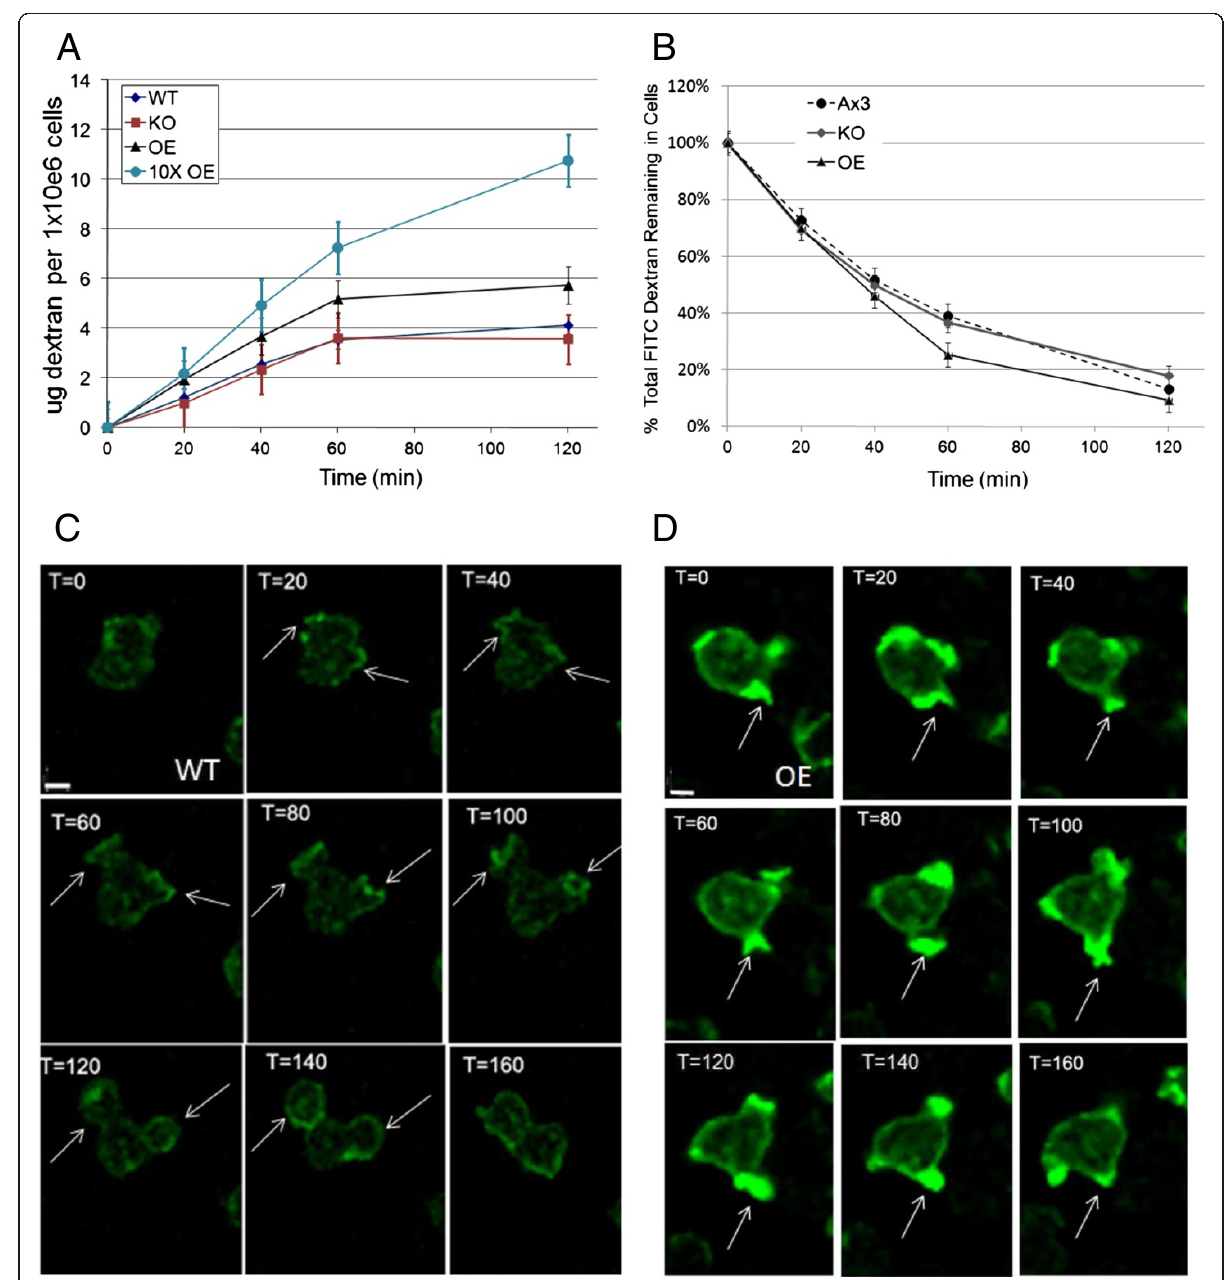
Figure 9 AmpA overexpression increases the rate of endocytosis but not exocytosis. A ) FITC dextran was added to cells in shaking culture to a final concentration of 2 mg/ml. Aliquots were taken every twenty minutes and prepared as described in methods. Fluorescence was read on a Bio-Rad fluorimeter. B ) Cells in shaking culture were incubated in FITC dextran as in A . They were then washed to remove extracellular FITC. Aliquots were taken every twenty minutes. The amount of FITC dextran present at Time = 0 was labeled as 100% for each cell type, and the FITC dextran remaining in the cell was taken as a percentage of the original amount . For A and B , error bars represent the standard error of the mean. The data represent the averages of a minimum of 5 separate determinations done on different days. C and D ) Overexpression of ampA causes multiple endocytic cups to form repeatedly at the same site. C ) Wt and D ) AmpA overexpressing cells containing the blasticidin resistant ABD- GFP plasmid were placed in chambered cover slips overnight. Images were taken every 20 seconds for 5 minutes. These images are representative slices from the time courses. Calibration bar = 6 um. Images of additional AmpA overexpressing cells undergoing endocytosis are shown in Additional file